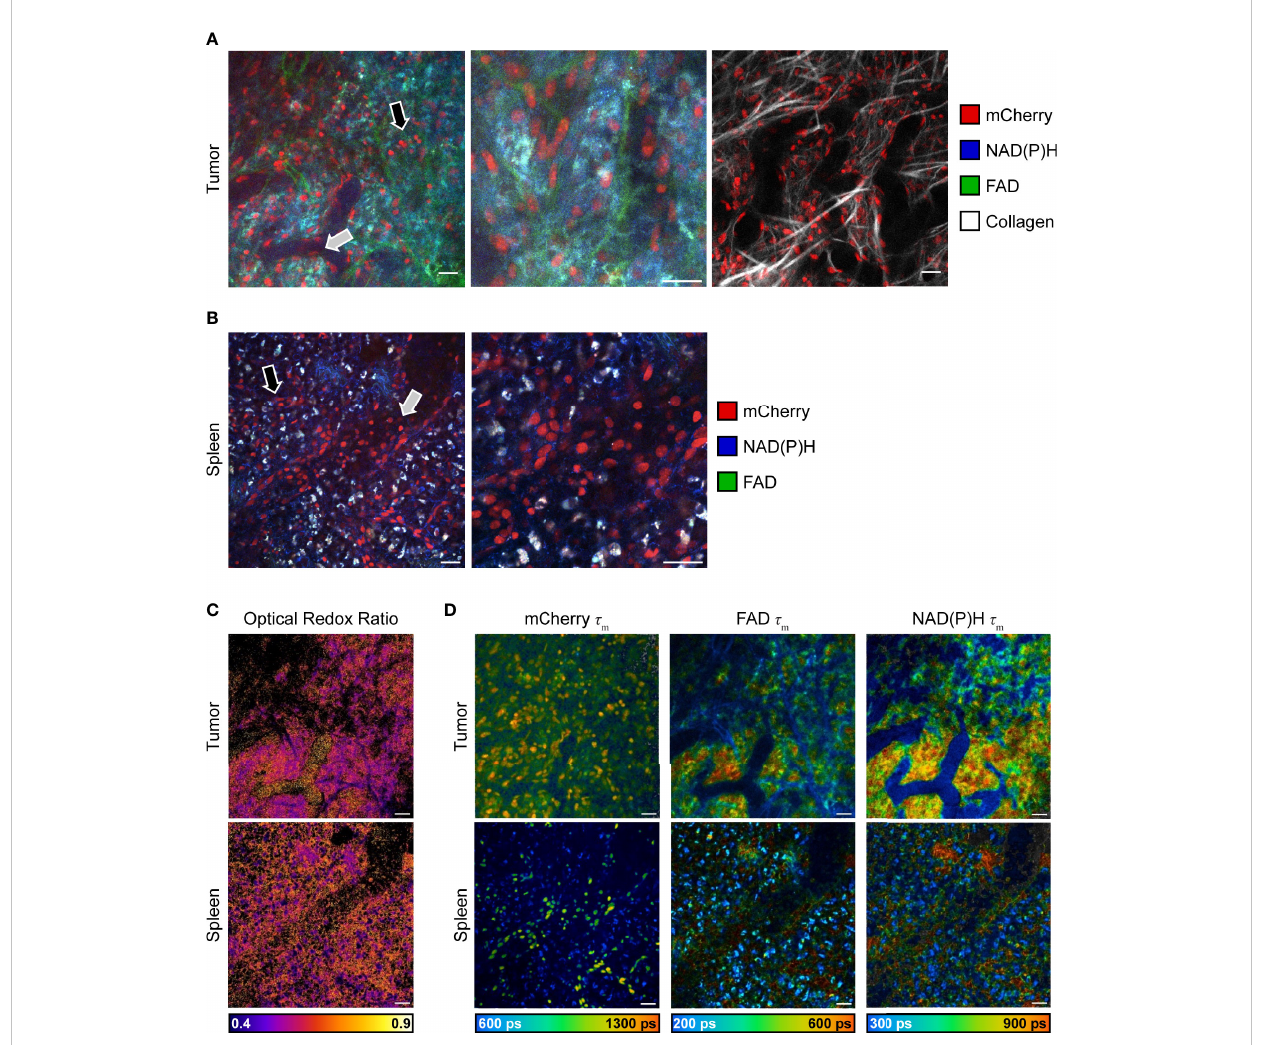
FIGURE 3 In vivo multiphoton images of immune and tumor cell populations. (A) Representative in vivo fl uorescence intensity images of B78 melanoma growing in an untreated CD4 mCherry reporter mouse, live during skin fl ap surgery. Images (left and center) of all fl uorophores show mCherry- expressing immune cells (red) in fi ltrating into tumor tissue (black arrow) and within vasculature (gray arrow) as well as auto fl uorescent NAD(P)H (blue) and FAD (green) expressed by all cells. Center image is a zoom of 2.0, inset from left image. Right image shows mCherry-expressing immune cells (red) interacting with collagen fi bers (white) within the tumor microenvironment. Scale bar 25 m m. (B) Representative ex vivo fl uorescence intensity images of spleen from untreated CD4 mCherry reporter mouse, spleen imaged immediately after euthanasia and excision. Images of all fl uorophores show mCherry-labeled immune cells (red) within spleen tissue (black arrow) and vasculature (gray arrow) as well as auto fl uorescent NAD(P)H (blue) and FAD (green) expressed by all cells. Right image is a zoom of 2.0, inset from left image. Scale bar 25 m m. (C) Optical redox ratio images (the intensity of NAD(P)H divided by intensity of NAD(P)H plus FAD) show cellular redox balance within tumor (top) and spleen